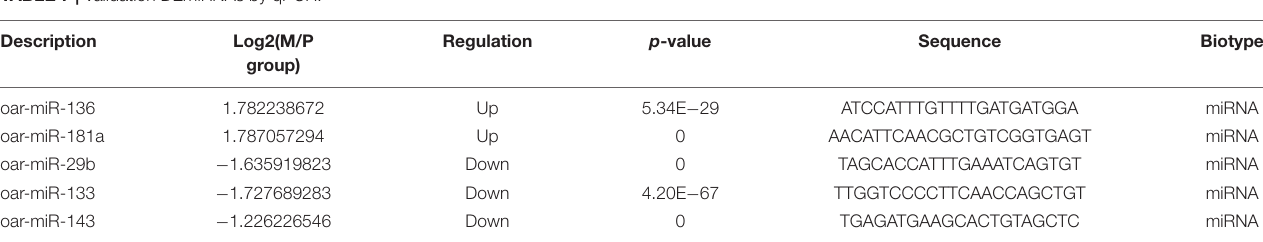
TABLE 7 | Validation DEmiRNAs by